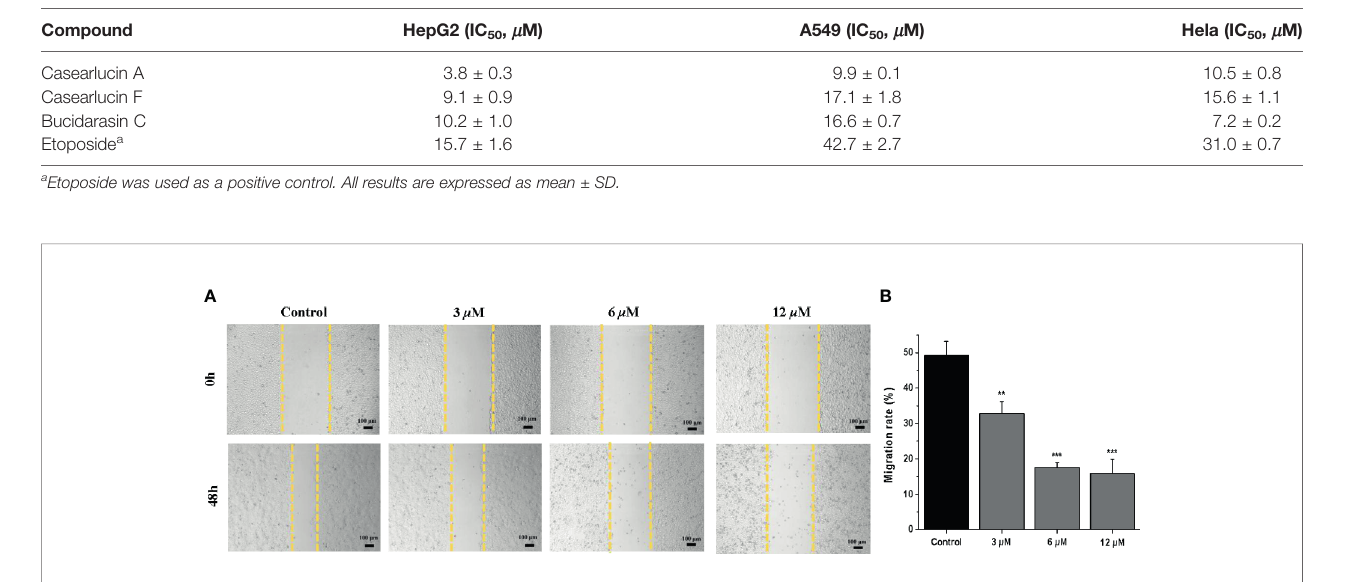
FIGURE 2 | Casearlucin A inhibited HepG2 cells in wounded healing assay. (A) HepG2 cells were photographed at 0 h and 48 h (scale bar: 100 m m). Data of Migration rate (%) were shown in (B) . DMSO was used as a negative control. The results are presented as means ± SD. ** p < 0.01, and *** p < 0.001 versus control